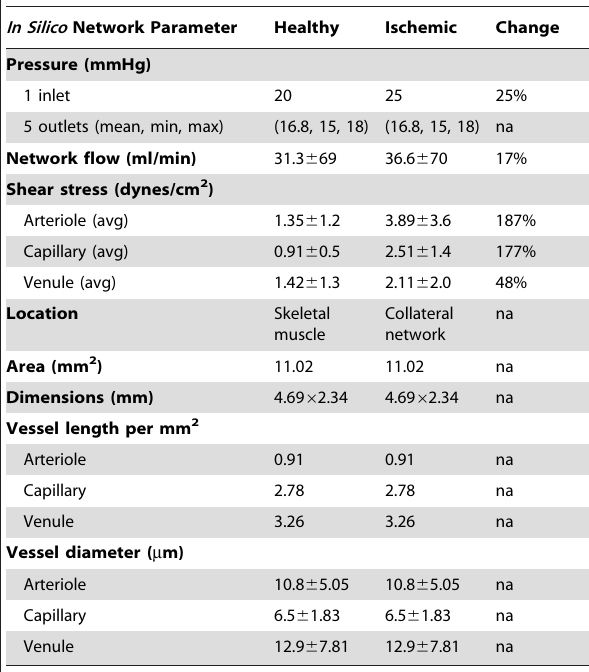
Table 1. Ischemic injury in a downstream collateral microvascular network was simulated by increasing the pressure at the feeder arteriole by